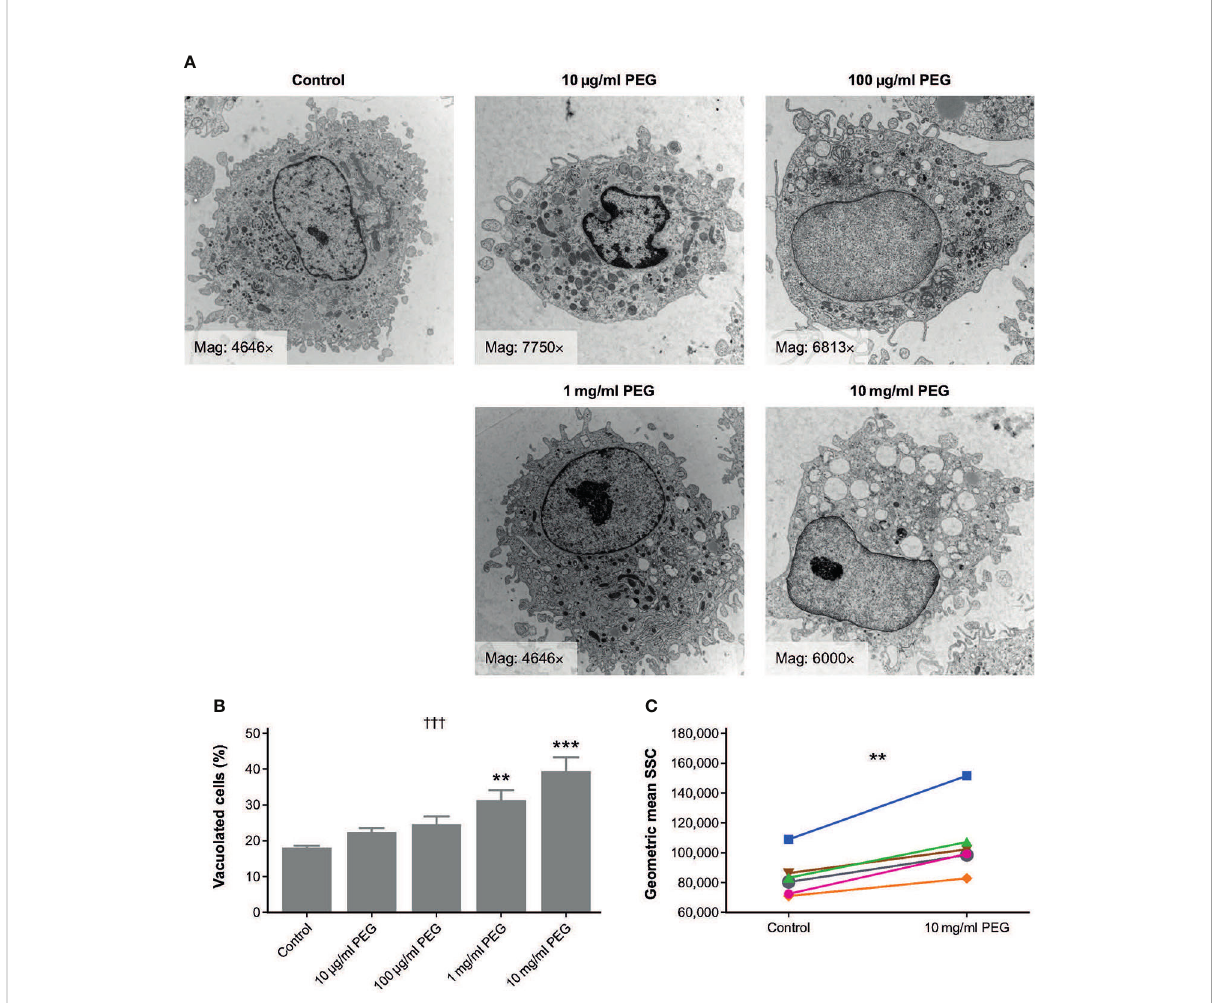
FIGURE 1 Effect of 24-hour exposure to 20-kDa PEG on vacuolation of human MDMs. (A) Representative TEM micrographs of MDMs from a single donor. (B) Mean (SD) frequency of vacuolated cells as assessed by light microscopy (n = 3). ††† p = 0.0002 (one-way ANOVA/Friedman ’ s test); ** p < 0.01, *** p < 0.001 versus control ( post-hoc test: Dunnett ’ s multiple comparison). (C) Granularity of MDMs assessed by fl ow cytometry (n = 6). ** p = 0.03 (Wilcoxon test). ANOVA, analysis of variance; MDM, monocyte-derived macrophage; PEG, polyethylene glycol; TEM, transmission electron microscopy; SD, standard deviation; SSC, side scatter